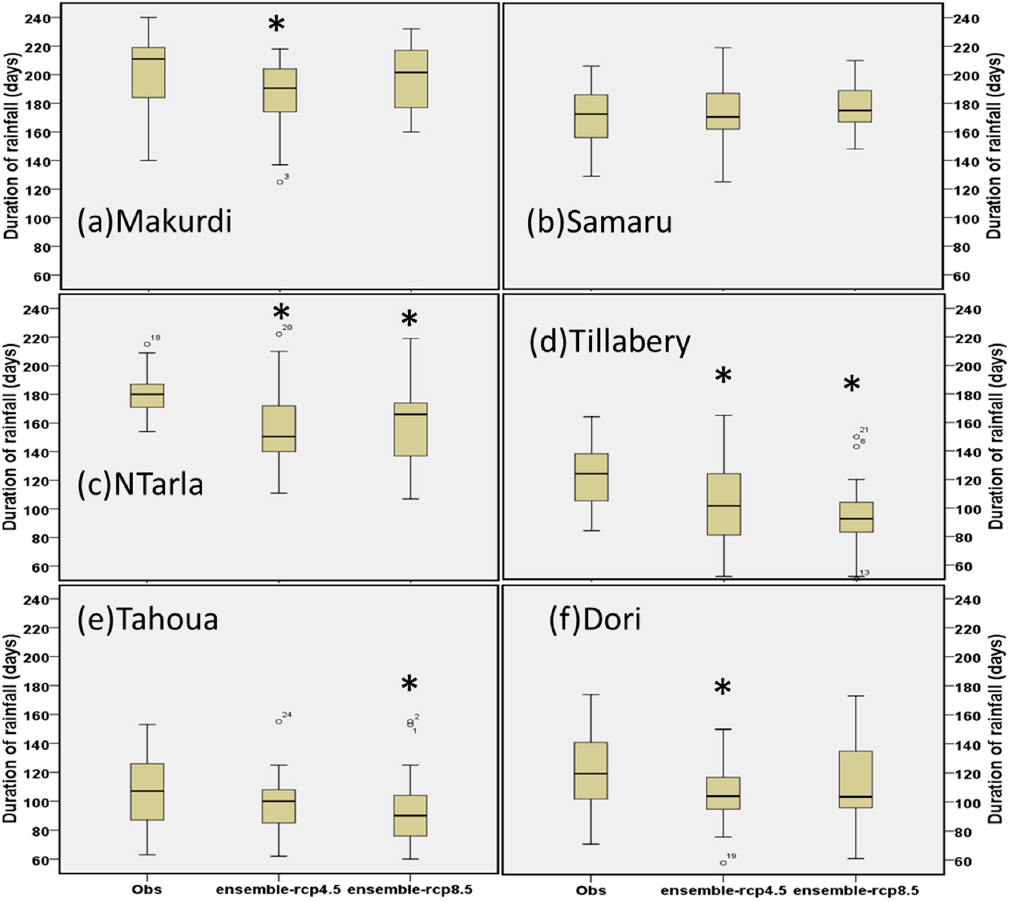
Figure 10. (a) Southern (Makurdi) and ( b , c ) Northern (Samaru and NTarla) Guinea and ( d – f ) Sahelian (Tahoua, Tillabery and Dori) average ensemble change in the duration of the growing season for the future period (2021/2025–2050) relative to the baseline (1976/1980–2005). Note, * indicates a significant change (p < 0.05). Table 5. Southern and Northern Guinea average ensemble change in the rainfall characteristic for the future period (2021/2025–2050) relative to the baseline (1976/1980–2005). All in Julian days.